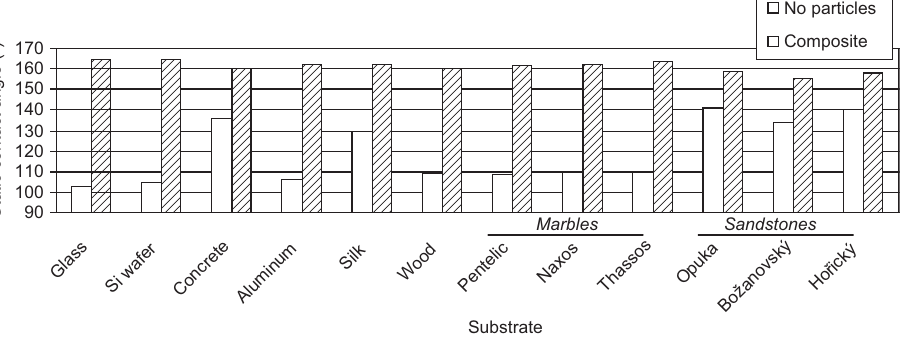
) measured on pure siloxane (no particles) and siloxane mixed with SiO S